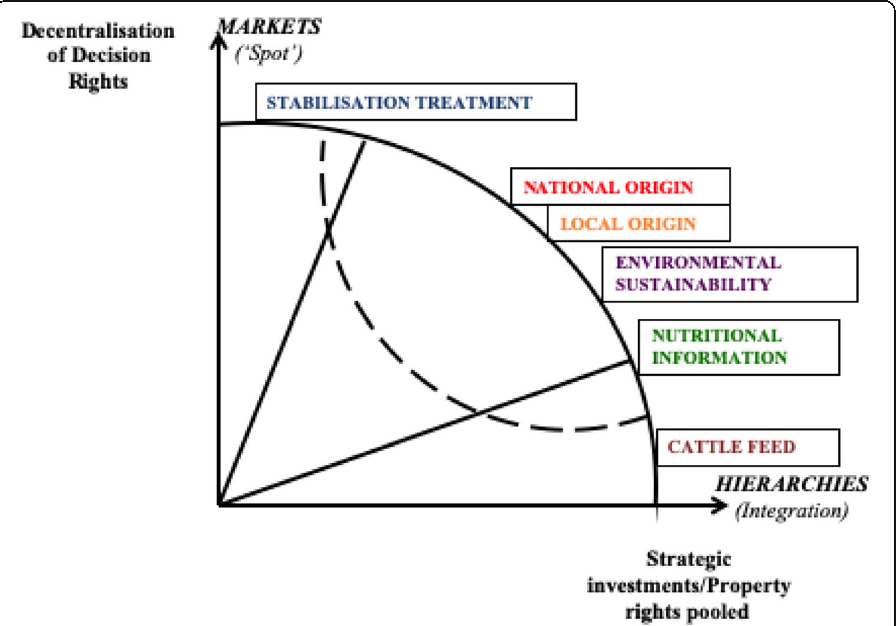
Fig. 4 Placement of label information based on consumers ’ behaviour. Source: Ménard 2013, 2017, 2018 and Martino et al.